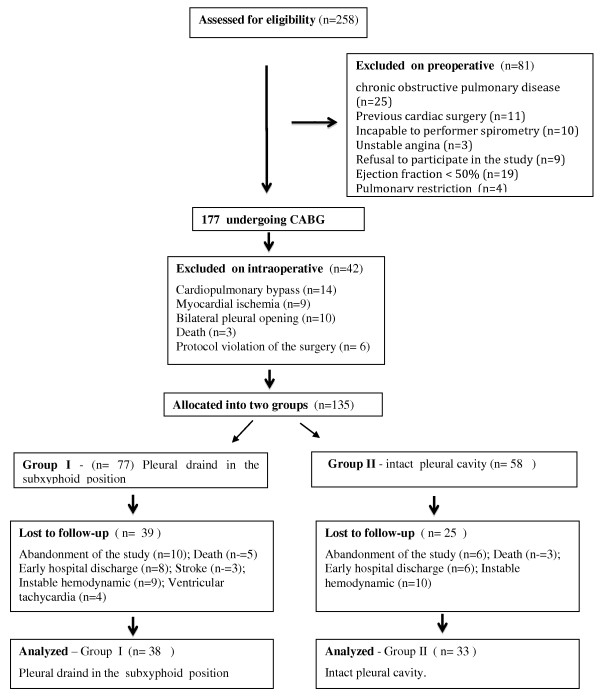
Participants flow.